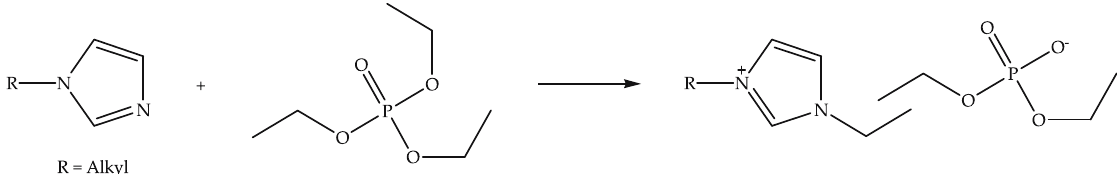
Figure 4: Schematic representation of the ethylation reaction of N - alkylimidazole with triethyl phosphate to synthesize the N - ethyl - N - alkylimidazolium diethyl phosphate ionic liquid.